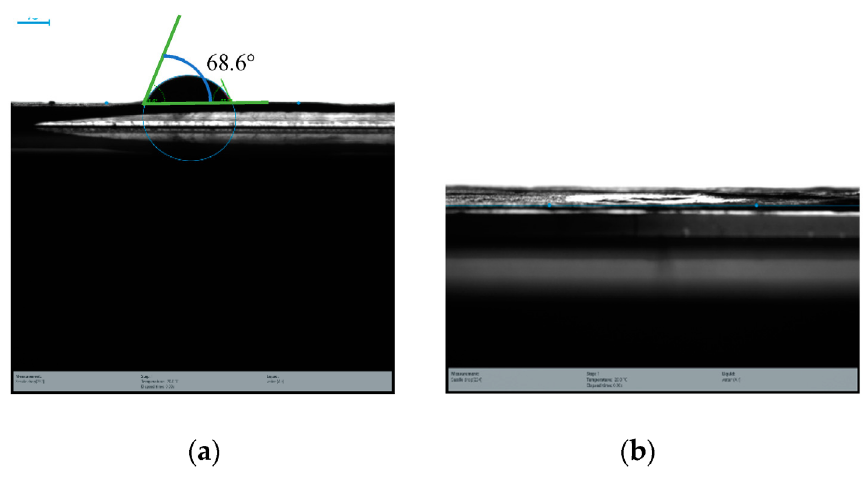
Figure 6. Static contact angle of ( a ) PAN membrane and ( b ) CS–GO-electrosprayed PAN–EN membrane.